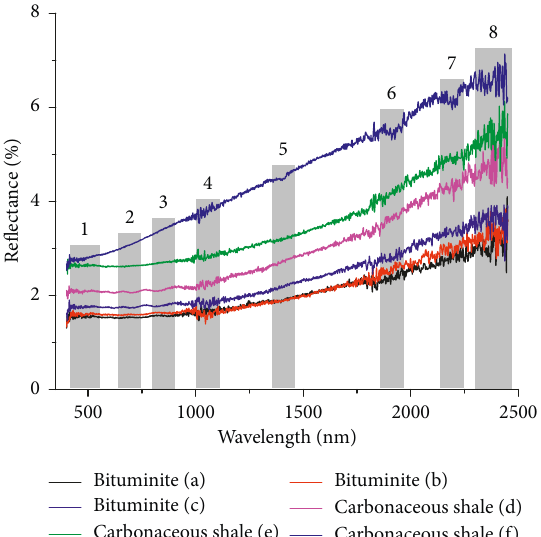
Figure 5: Spectral reflectance curves of the six representative samples in Figure 1 in the wavelength range of